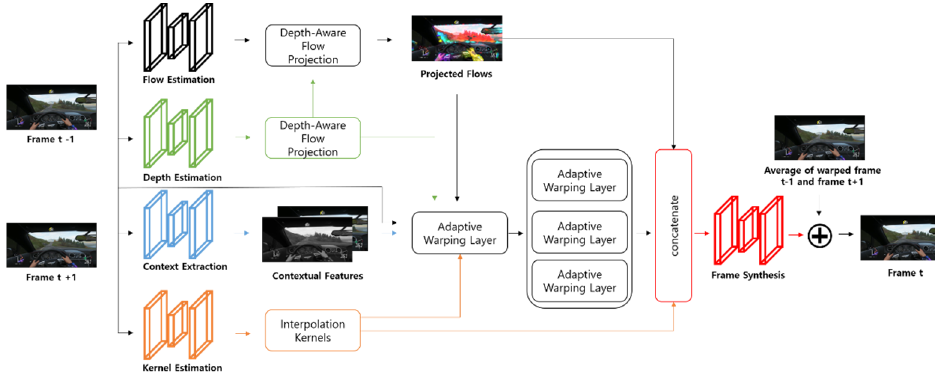
Figure 4. Architecture of the DAIN model.